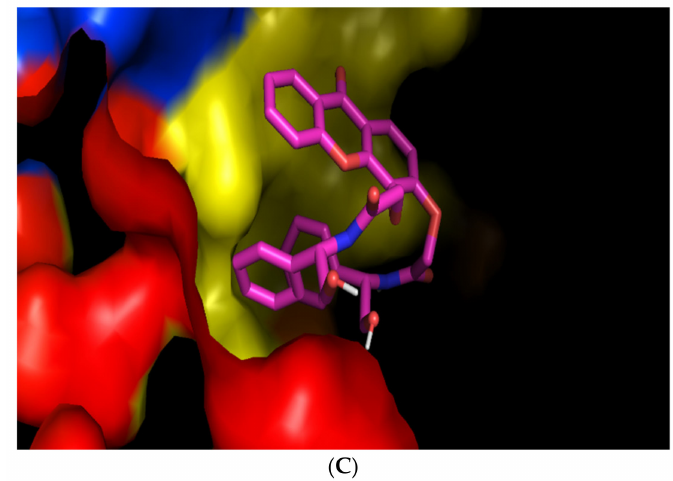
Figure 3. Molecular visualization of ( R , R )-8 (blue) and ( S , S )-8 (pink) in the BCR of the homology model of NorA; ( A ) interaction of ( R , R )-8 with key residues; ( B ) surface view of ( R , R )-8 inside a pocket; ( C ) visualization of ( S , S )-8 at the surface of the homology